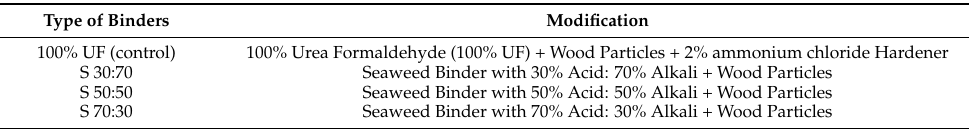
Table 2. Four types of seaweed binder with modifications using acid and alkali.